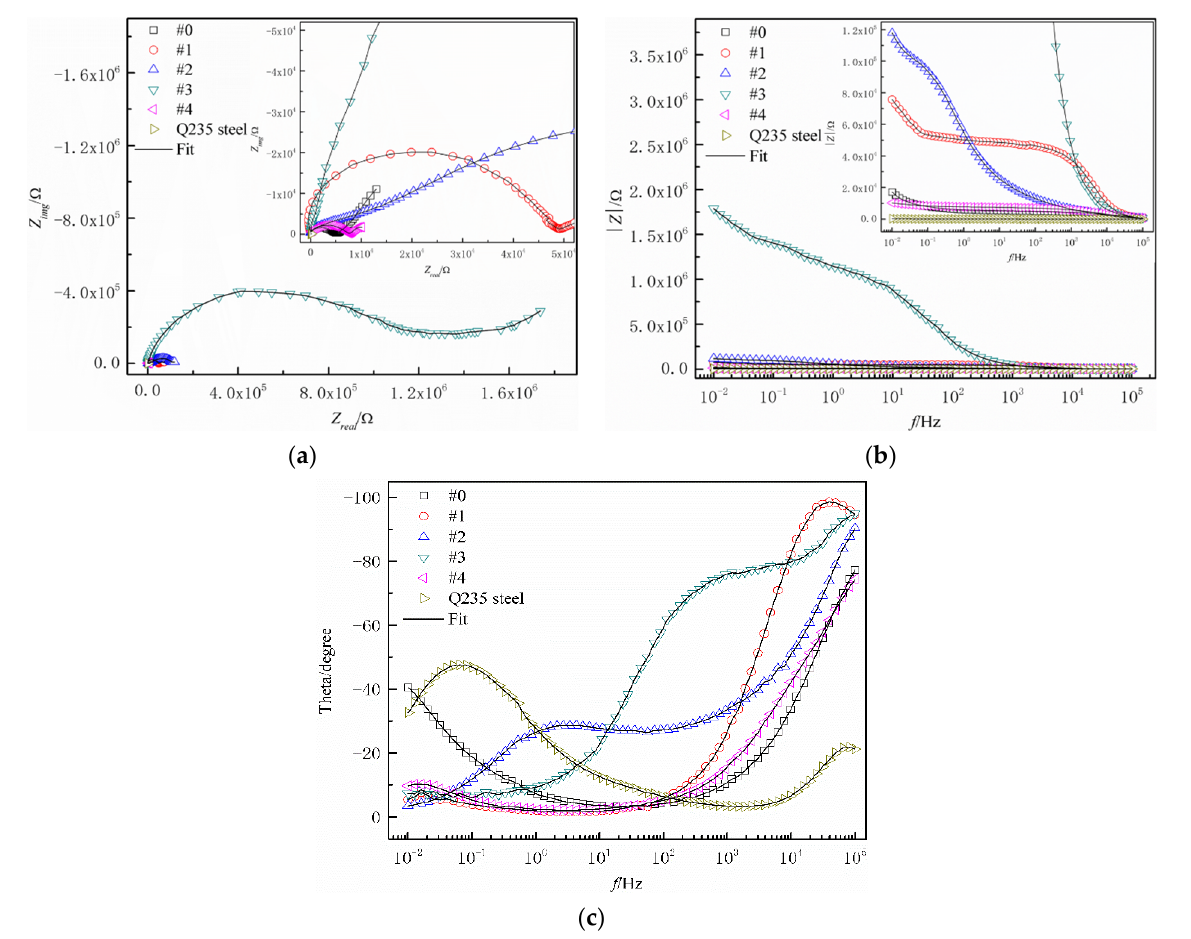
Figure 6. ( a ) Complex plane impedance spectra, ( b ) |Z|- f , and ( c ) θ - f for the WPU SCCs with modified fillers immersed in NaCl solution.